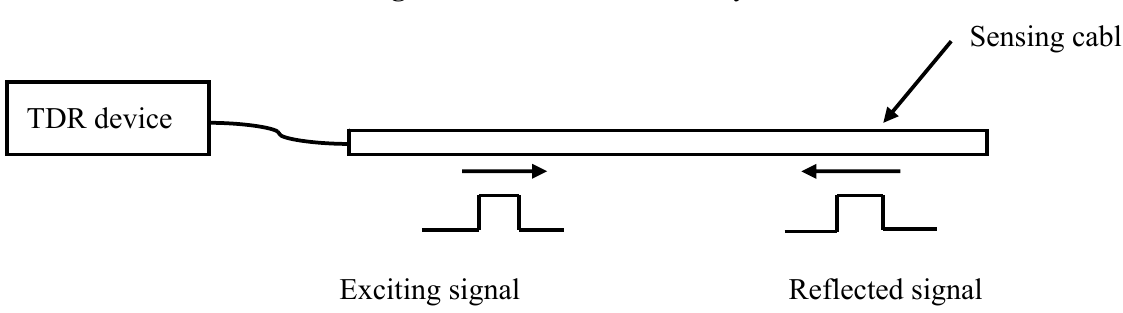
Figure 1. TDR measurement